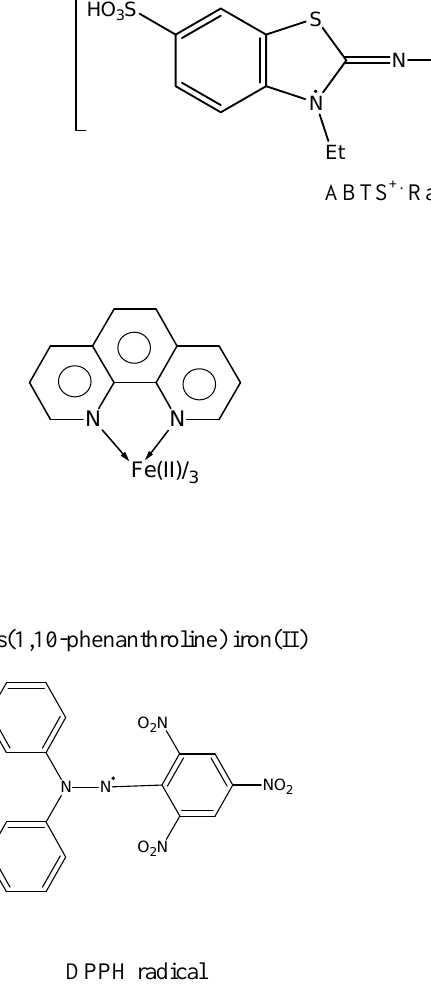
Figure 3. Basic chromophores used in TAC (total antioxidant capacity) assays.